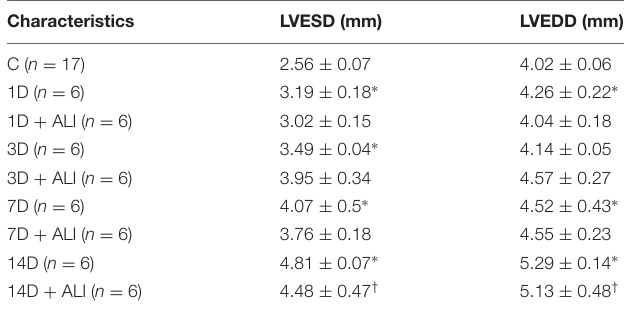
TABLE 1 | Myocardial infarction (MI) mice characteristics of the echocardiographic analysis.